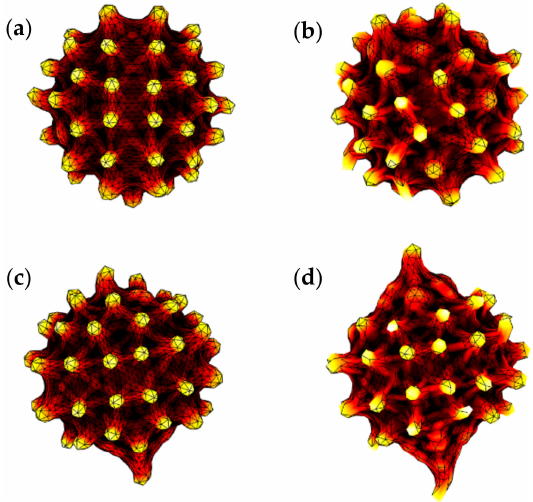
Figure 12. The recovered stretched cell shapes of day 42 sphero-echinocyte RBCs with ( a ) 0% and ( b ) 25% of defective vertical interactions ( A Vertical ) at optical tweezers stretching forces of F ext = 60.0 pN, and that of RBCs having ( c ) A Vertical = 0% and ( d ) A Vertical = 25% at F ext = 200.0